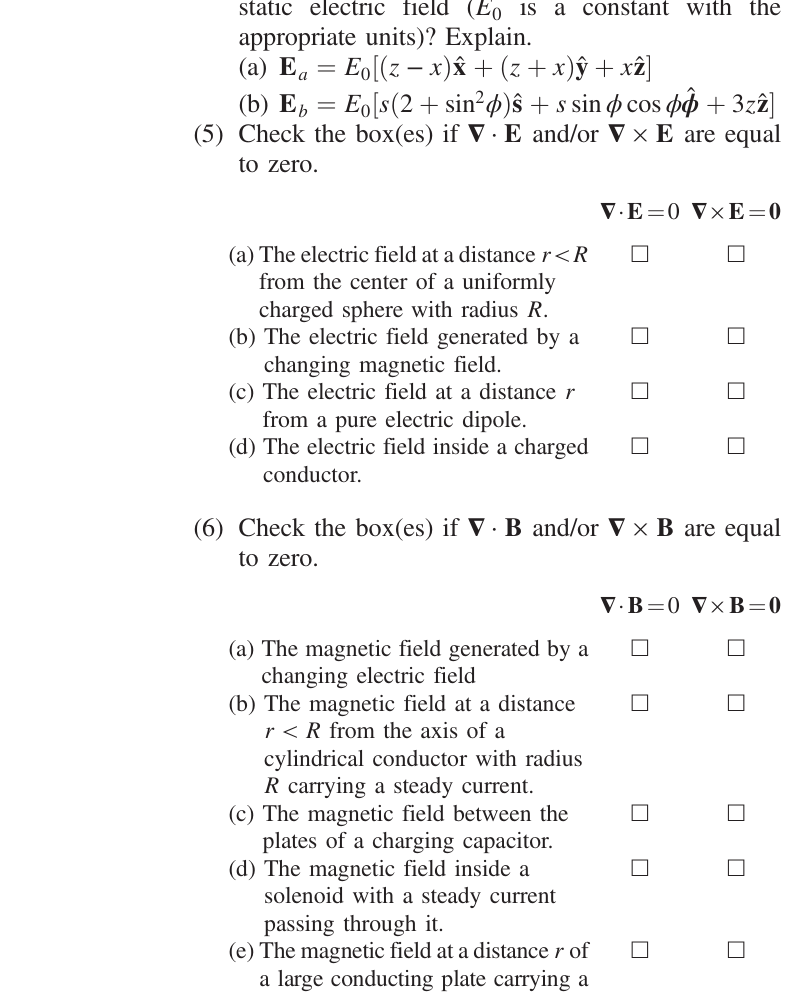
FIG. 11. Post-test field